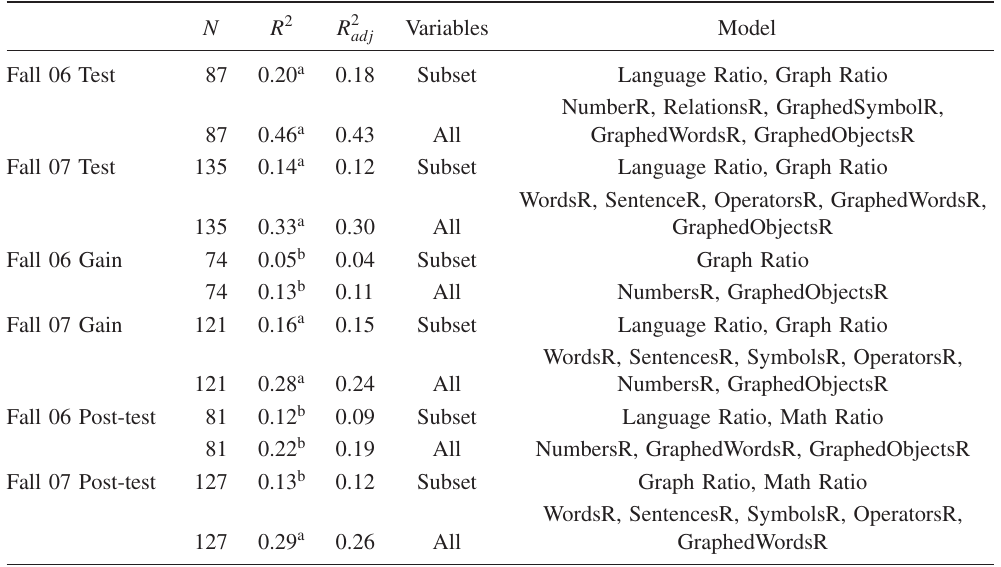
TABLE V. Regression with Scaled Variables: All variables were scaled by dividing by the total elements. The “ R ” postfix represents a scaled variable, a variable that has been divided by Total Elements. Subset models may contain only the variables Language Ratio, Graph Ratio, or Mathematics